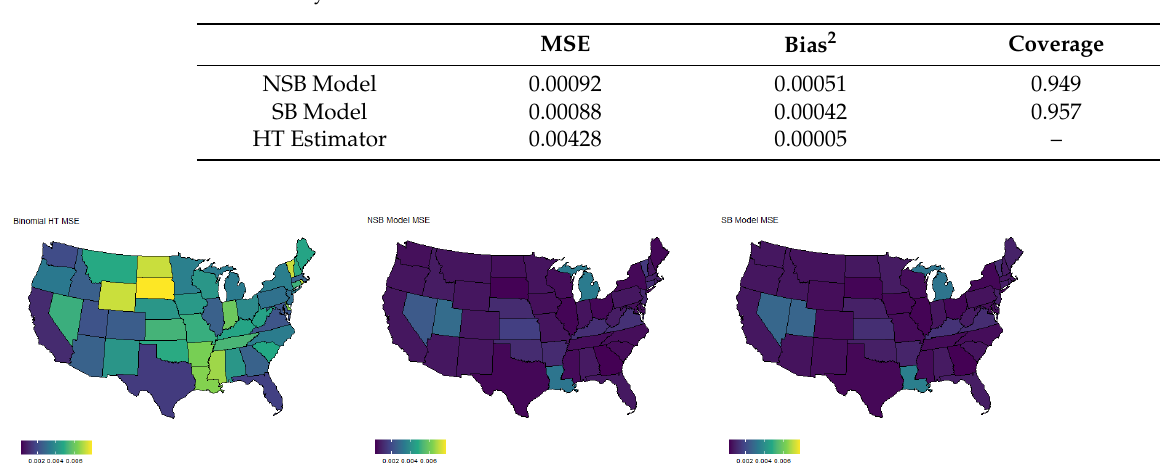
Table 1. Binomial simulation MSE, squared bias, and 95% credible interval coverage rate. The results are averaged across the 49 geographic areas. Simulated data are based on Week 1 of the Household Pulse Survey.